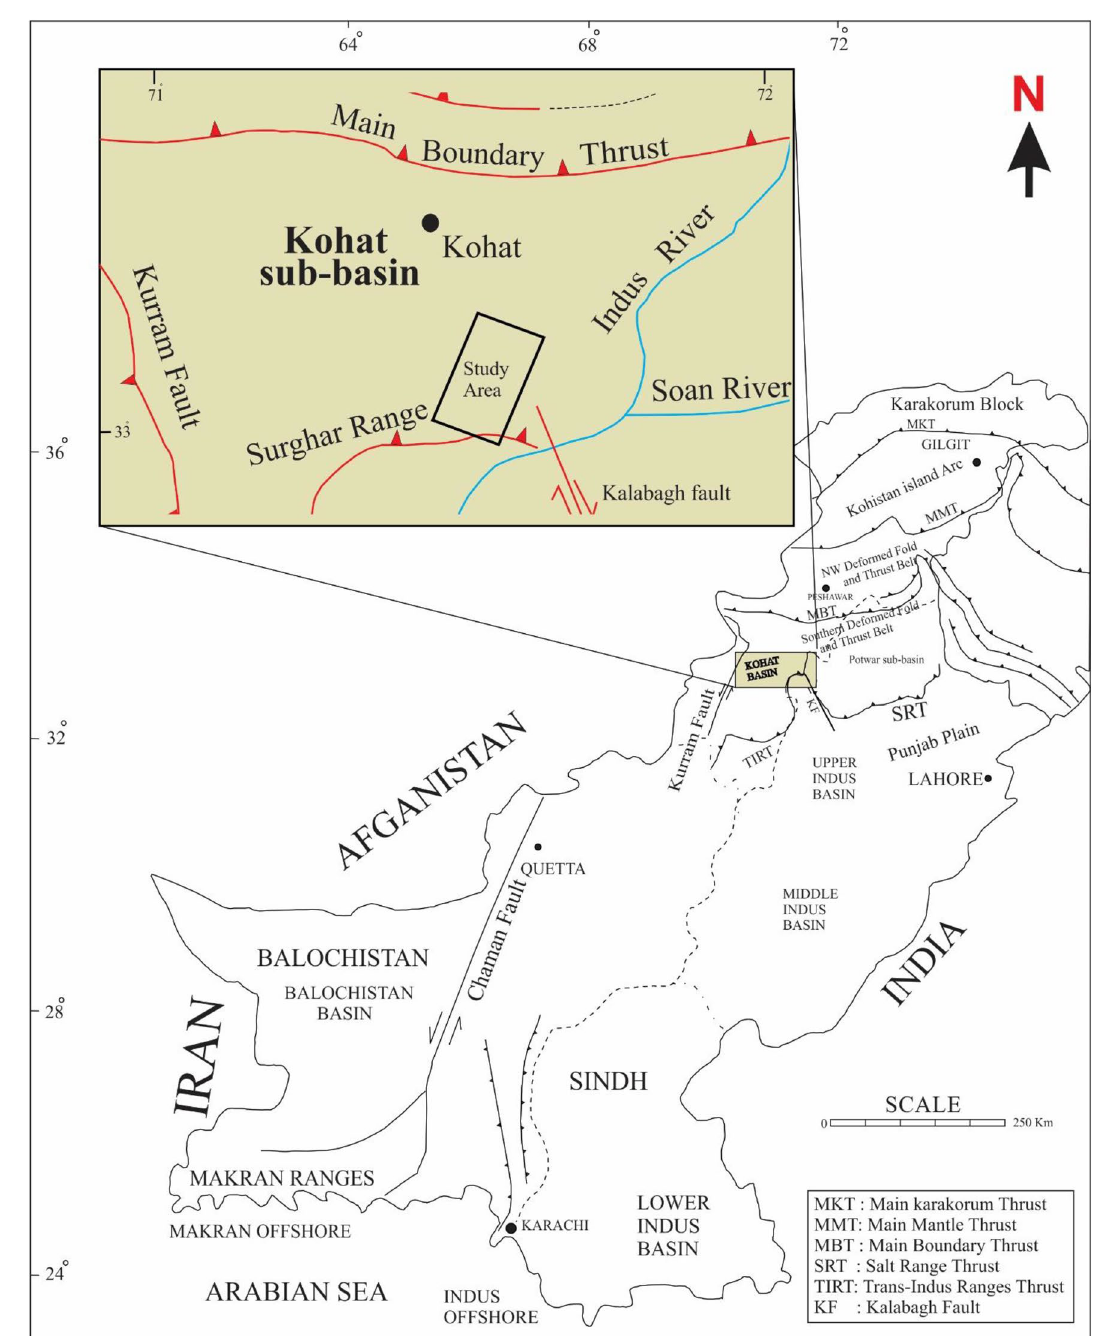
Fig. 1 Tectonic map of Pakistan showing the major tectonic features and the location of the study area (after Ahsan and Chaudhry